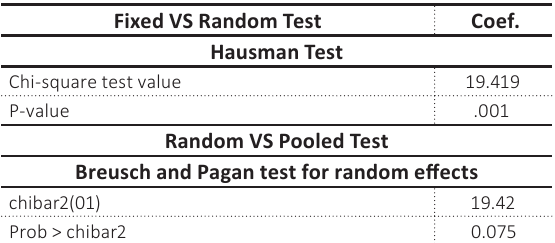
Table 4. Hausman test and Breusch and Pagan test